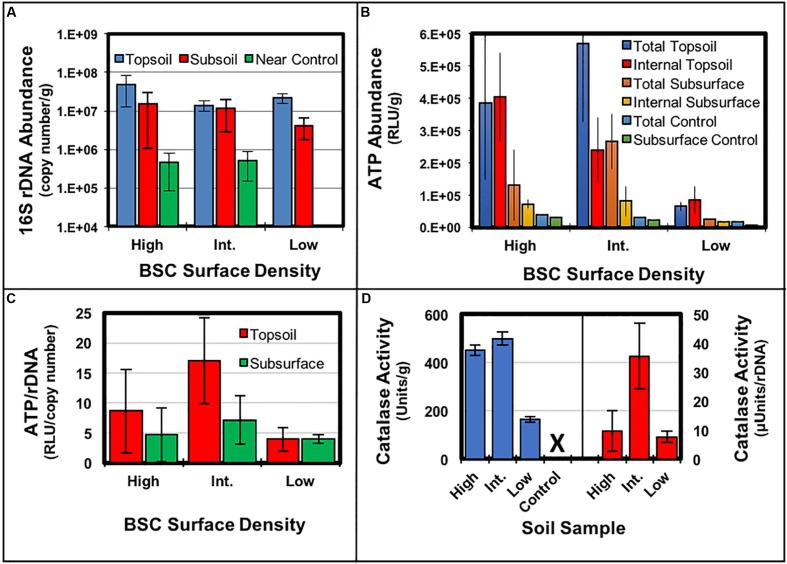
Comparison of molecular measurements across the transect and along the vertical BSC column: (A) 16S rDNA gene copy numbers, (B) ATP abundances in units of Relative Light Units (RLU) per gram of soil, (C) ATP specific activities in units of RLU per copy number of 16S rDNA, and (D) catalase specific activities expressed in both Units/g soil (blue, left axis) and μUnits/copy number of 16S rDNA (red, right axis); error bars represent the standard deviation (n ≥ 3) and ‘X’ denotes no measurable activity.